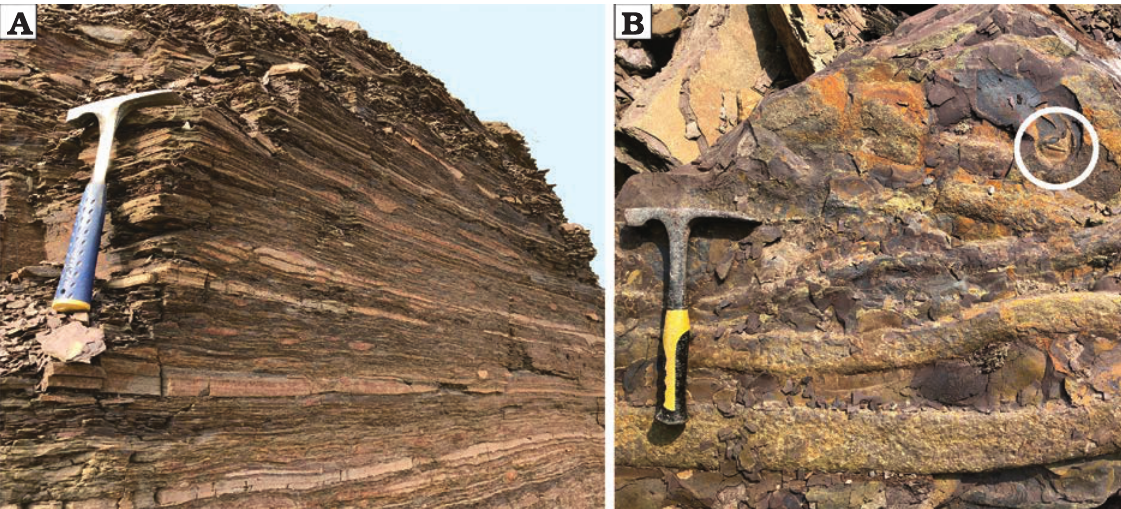
Fig. 2. Alternating dark purple mudstone and sandstone yielding Phantaspis auritus gen. et sp. nov. A . Vertical face. B . Surface of bed, showing the gutter cast; not circled trilobite. The length of both hammers is 28